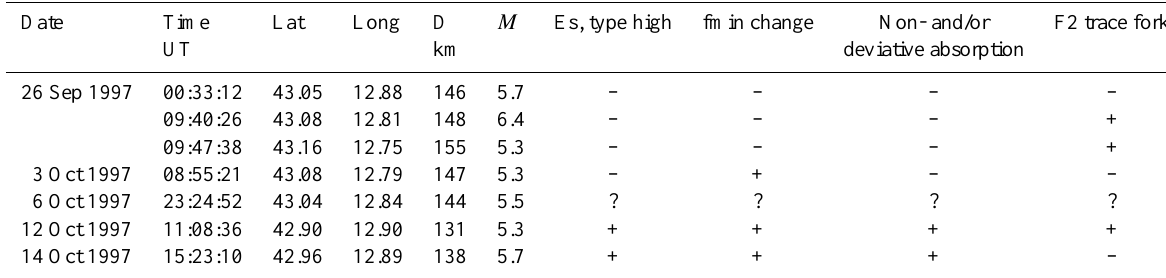
Table 3. Ionospheric transients prior to EQs with M> 5. Distances between station and EQ epicenter are less than 200km (Rome station,